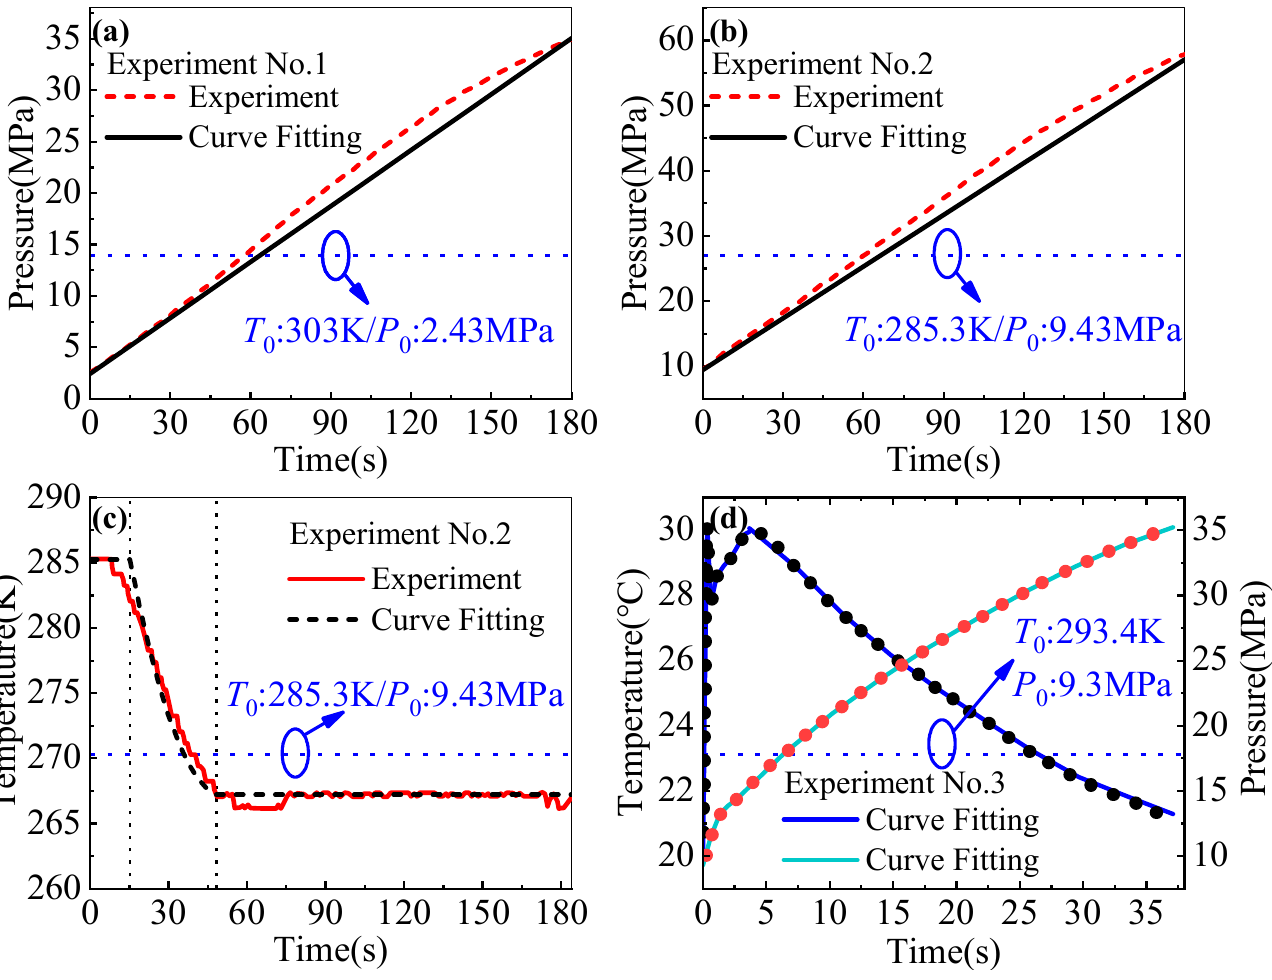
Figure 2. (a) Inlet pressure and initial conditions with constant inlet temperature 303K of experiment No. 1 [27]; (b),(c) Inlet pressure, temperature and initial conditions of experiment No. 2 [27]; (d) Inlet pressure/temperature and initial conditions of experiment No. 3